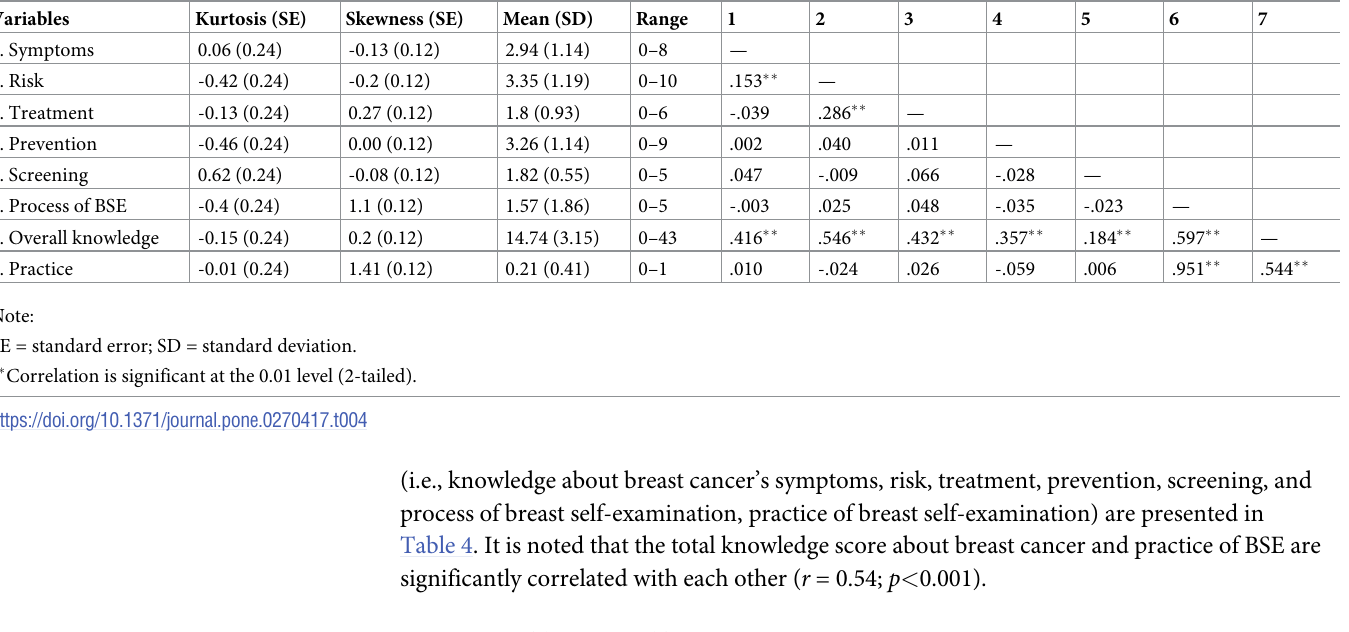
Table 4. Descriptive statistics, and correlations between all outcome variables.